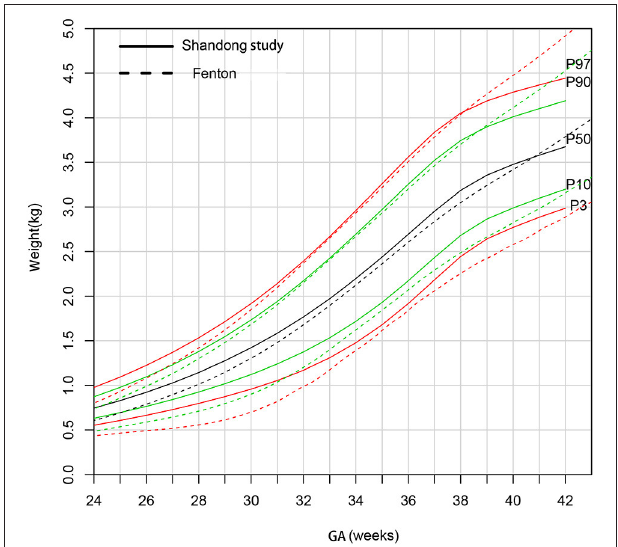
FIGURE 2 | Comparison of birthweight (kg) curves by gestational age among the present study, CNNS and INTERGROWTH-21st Newborns Size Standards/ References (female).